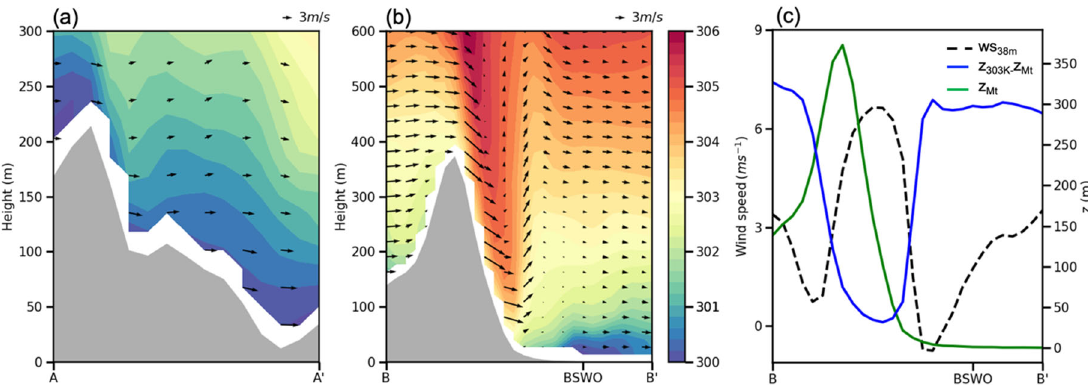
Figure 7. Vertical cross-sections of wind vectors and virtual potential temperature at 05:30 LST along ( a ) line AA ′ and ( b ) line BB ′ in Figure 6e; ( c ) variation in terrain height (green line), wind speed at 38 m (black dashed line), and layer thickness between the surface and the height of virtual potential temperature of 303 K (blue line) along the line BB ′ . In ( a ) and ( b ), the vertical velocity is multiplied by 3, and color bars represent the virtual potential temperature (K).